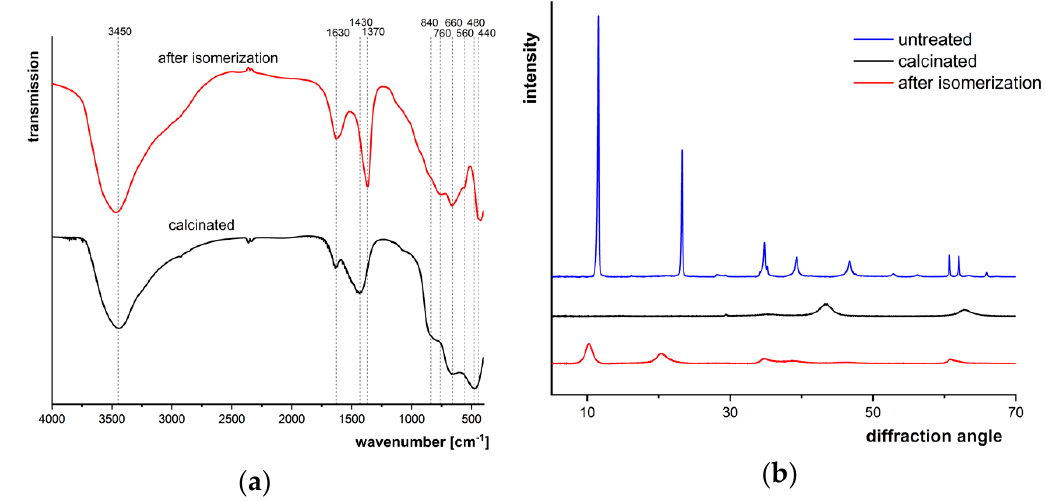
Figure 5. ( a ) IR spectra and ( b ) XRD pattern of hydrotalcite; reaction conditions: c glucose = 5 g / L, pH ≈ 7, air atmosphere, T = 100 °C, t = 40 min, m catalyst /m glucose = 0.2.